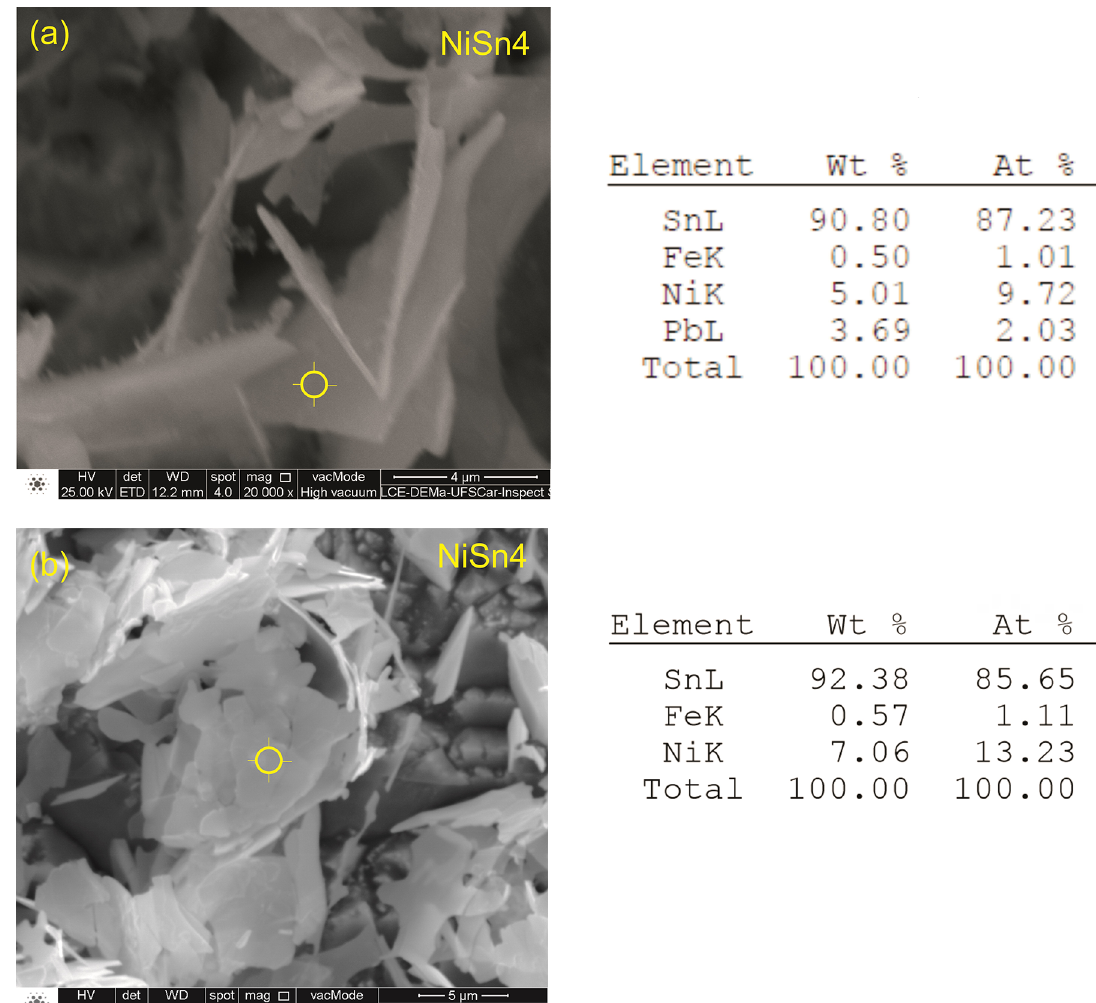
Figure 9. Compositions by SEM-EDS of the plate-like intermetallics related to the NiSn4 eutectic phase in both the eutectic (a) Sn- 0.2wt%Ni and the hypereutectic (b) Sn-0.5wt%Ni